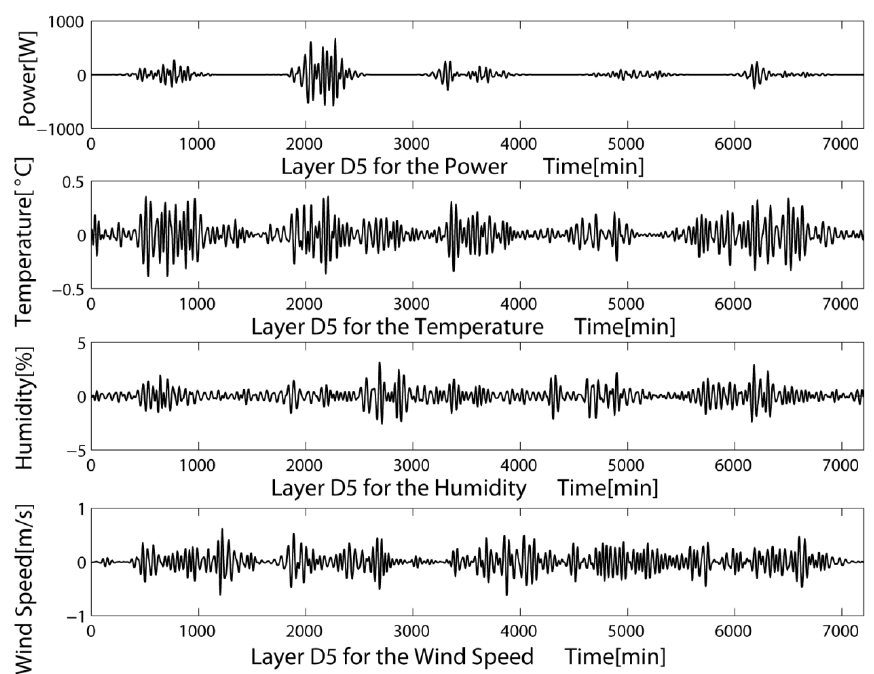
Figure 9. D5 layer comparison of different signals.